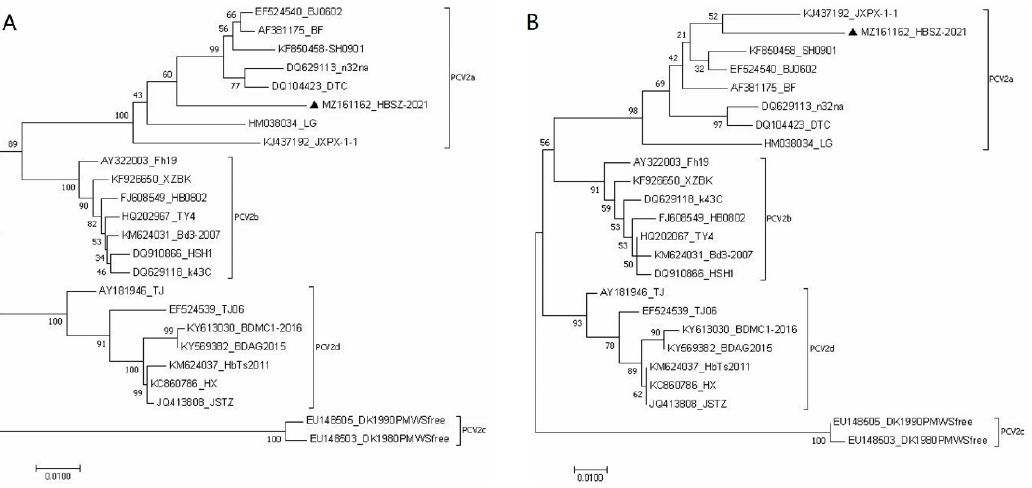
Figure 3. Phylogenetic trees of PCV2 HBSZ-2021 strain and the reference strains based on the ORF2 nucleotide and amino acid sequences. ( A ) Nucleotide sequences; ( B ) Amino acid sequences. The information of PCV2 reference strains is shown in Table 2. ▲ The detected strain HBSZ-2021.